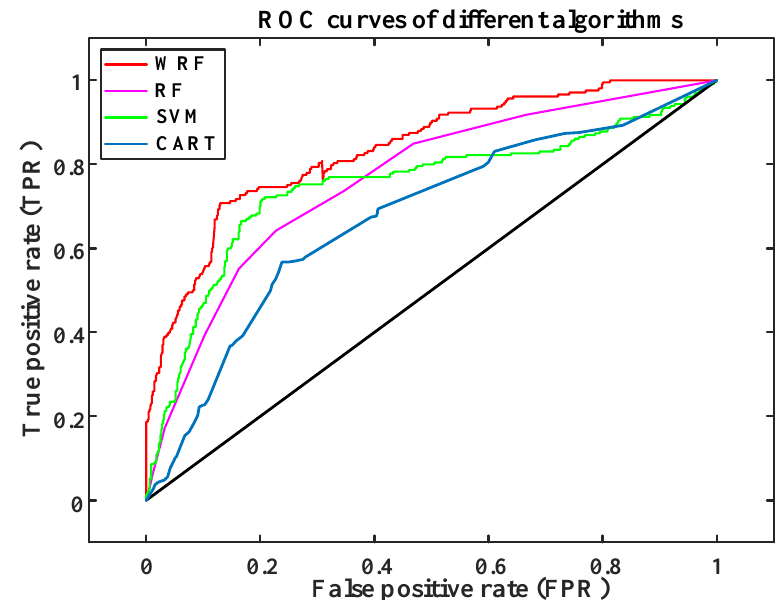
Figure 7. ROC curve of empty-nest user recognition based on different algorithms.